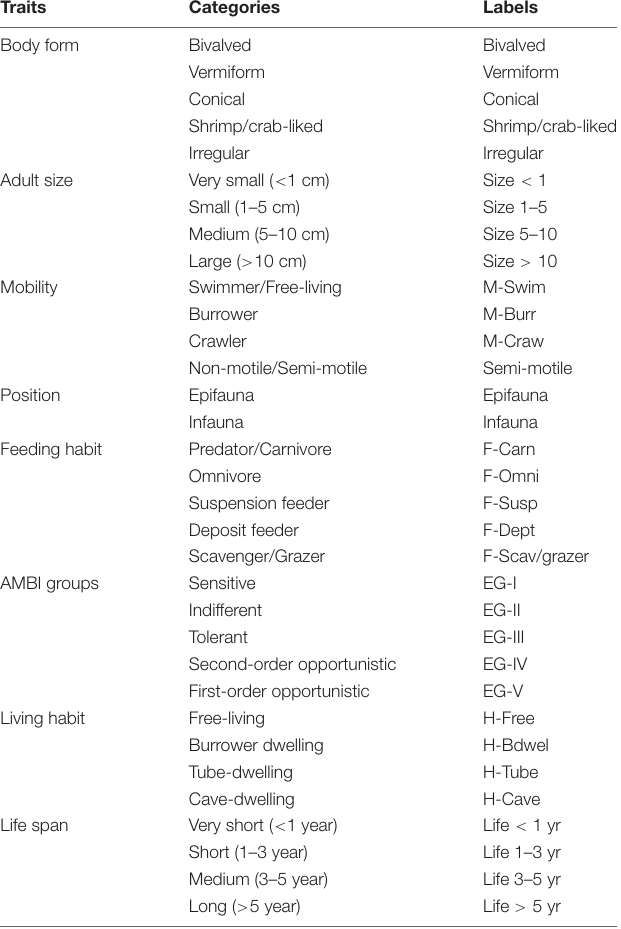
TABLE 1 | Definition and labels of the 8 traits (33 categories) used to describe macrobenthos.